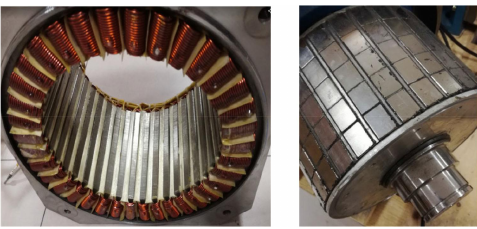
Figure 8. Rotor and Stator of one motor experimentally tested (Motor ID